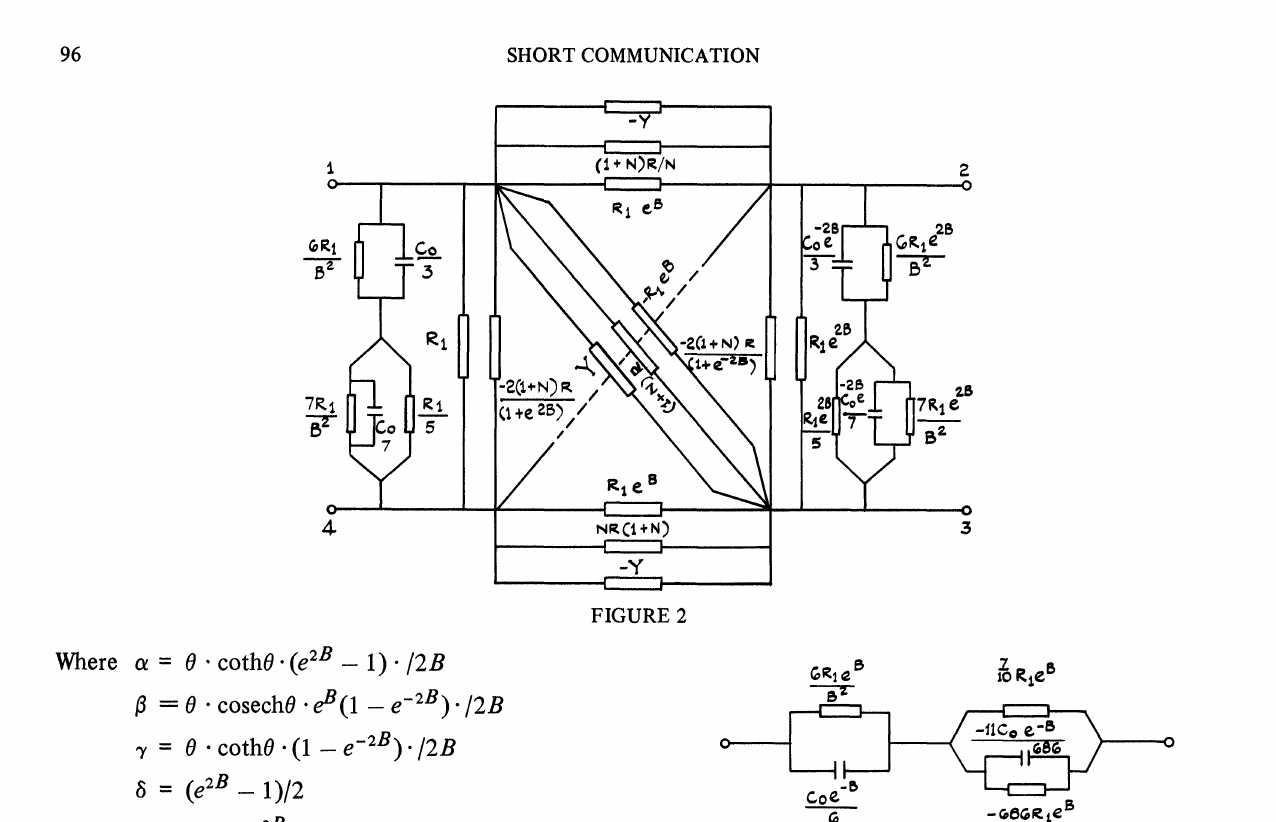
new and accurate lattice equivalent of the exponen- tially tapered R-C-NR structure (Figures 2 and 3). The model is deemed to be extremely versatile, powerful and useful. It may be noted that for k 0 the model reduces to that given earlier for the uniform R-C-NR structure, 6 and for k 0, N 0 reduces to the model postulated earlier for uniform RC structure. This conforms to expectations and serves as